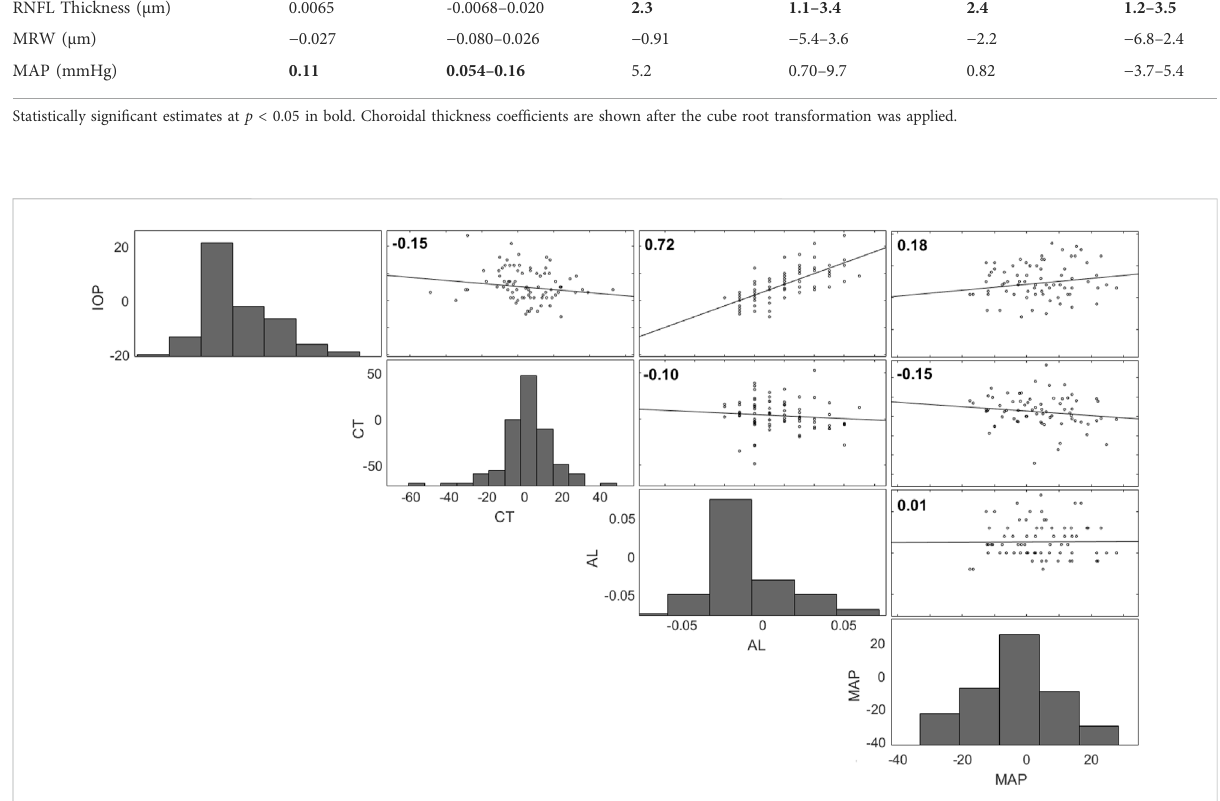
FIGURE 6 Correlation matrix for IOP, choroidal thickness (CT), axial length (AL), and MAP (all changes from seated). Each dependent variable is plotted on every one of the axes along the row or column that the respective histogram is